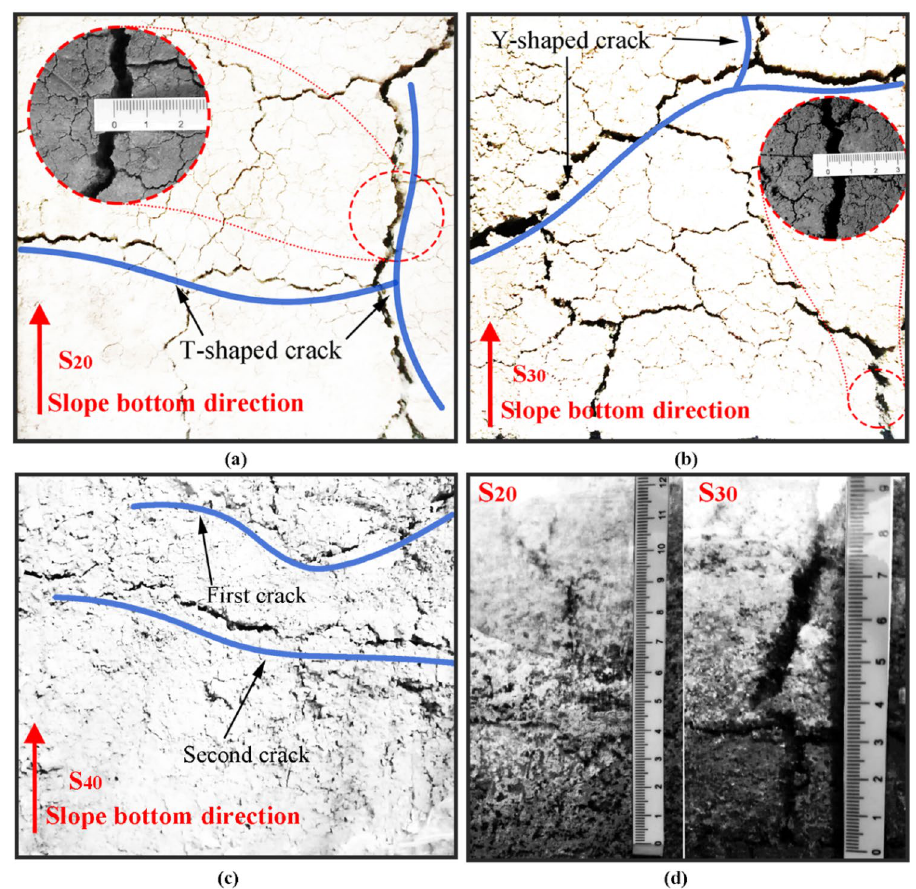
Figure 3. Cracks in the slope after 5 freeze–thaw cycles: cracks on the top of ( a ) S 20 , and ( b ) S 30 , and ( c ) S 40 , and ( d ) cracks on the lateral side of S 20 and S 30